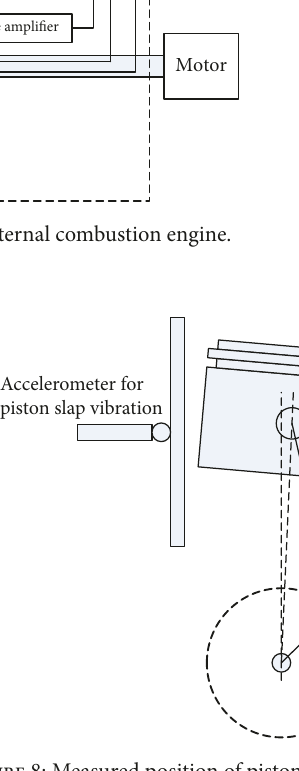
Figure 8: Measured position of piston slap